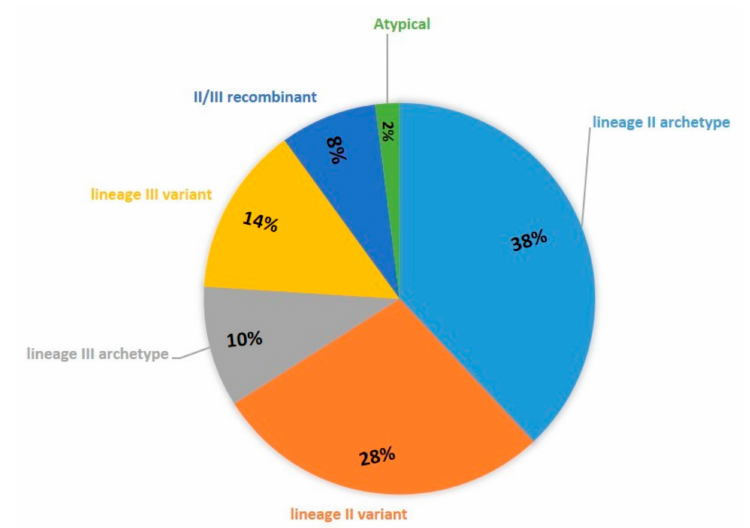
Figure 1. Population structure of T. gondii in Serbia ( n = 50